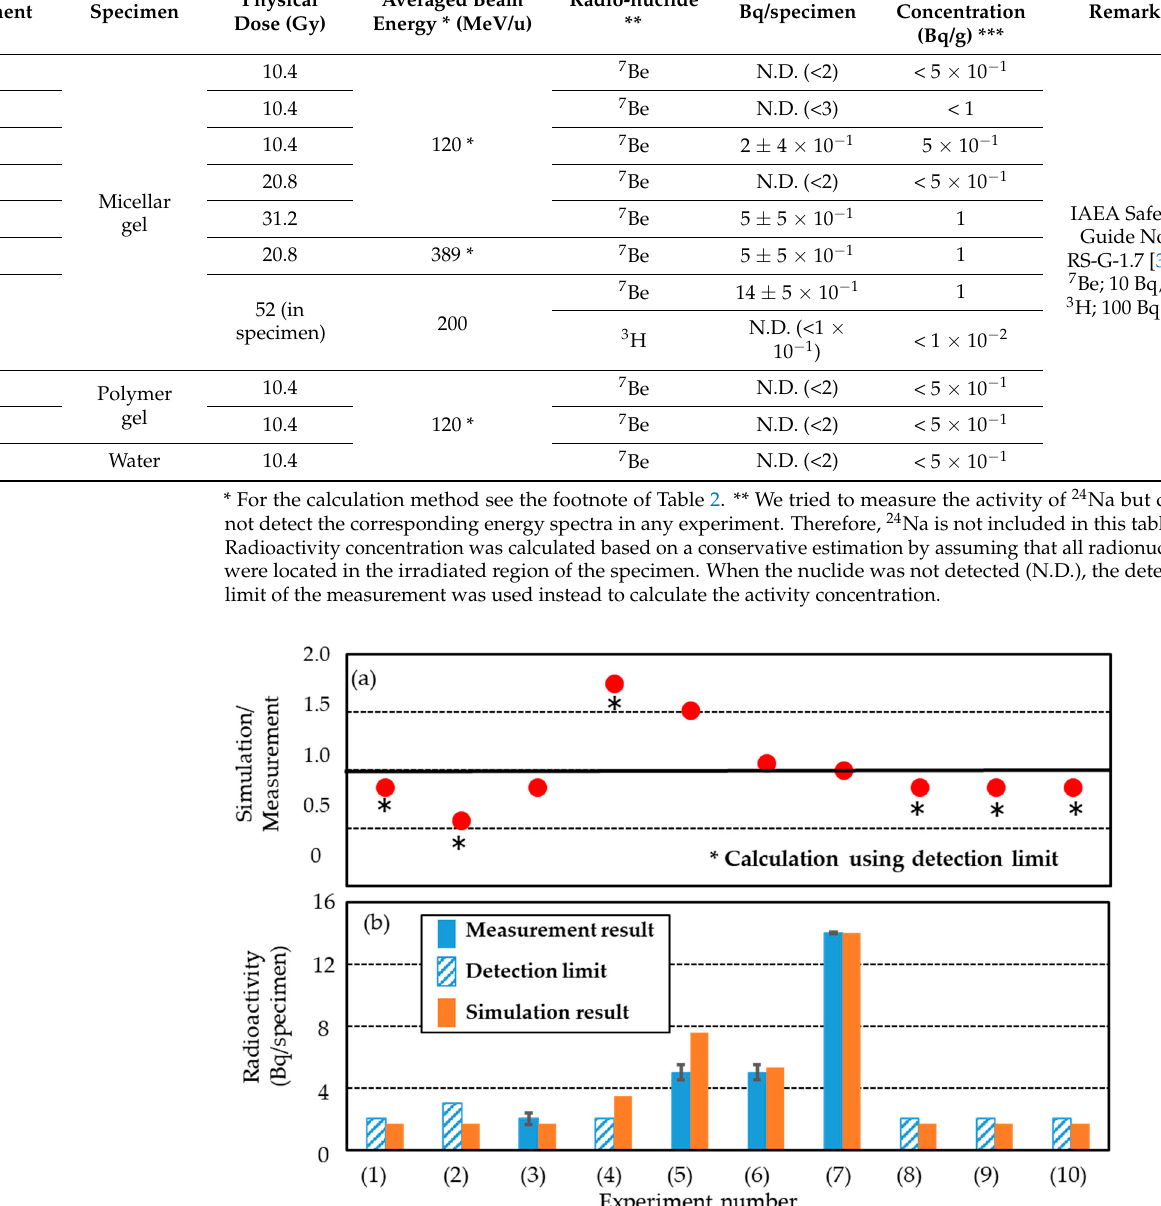
Table 5. Measured radioactivity in all the experiments after irradiation by carbon ion beams.